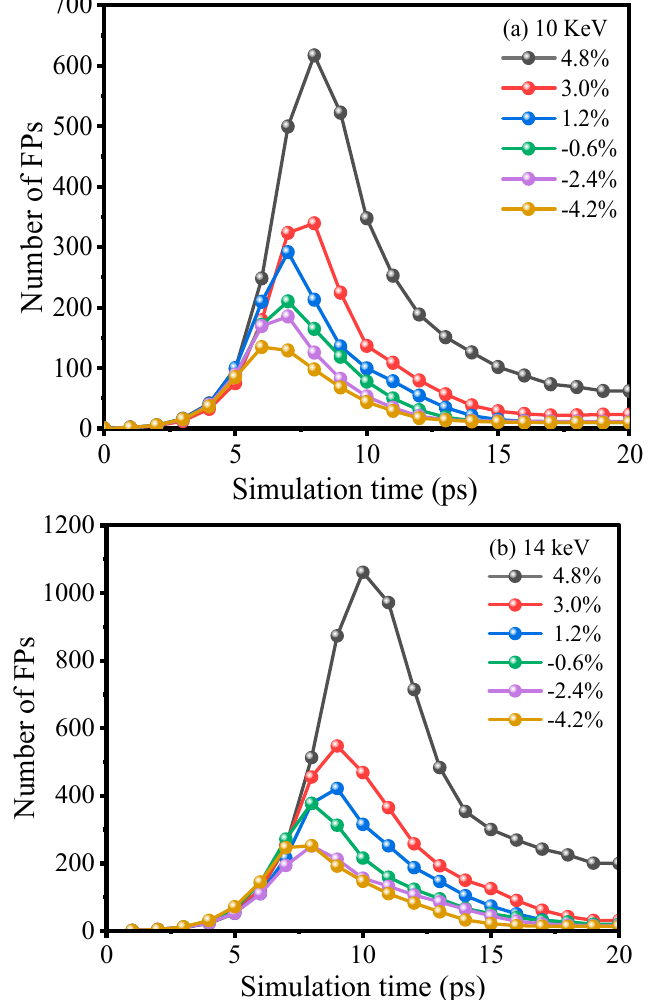
Figure 1. The number of Frankel pairs (FPs) produced during the collision cascades of ( a ) 10 keV and ( b ) 14 keV PKA for strain resulted in volume changes ranging from − 4.2 to 4.8%. Each point represents the average of four distinct directions and four distinct timings, i.e., sixteen distinct sam ‐ ples.